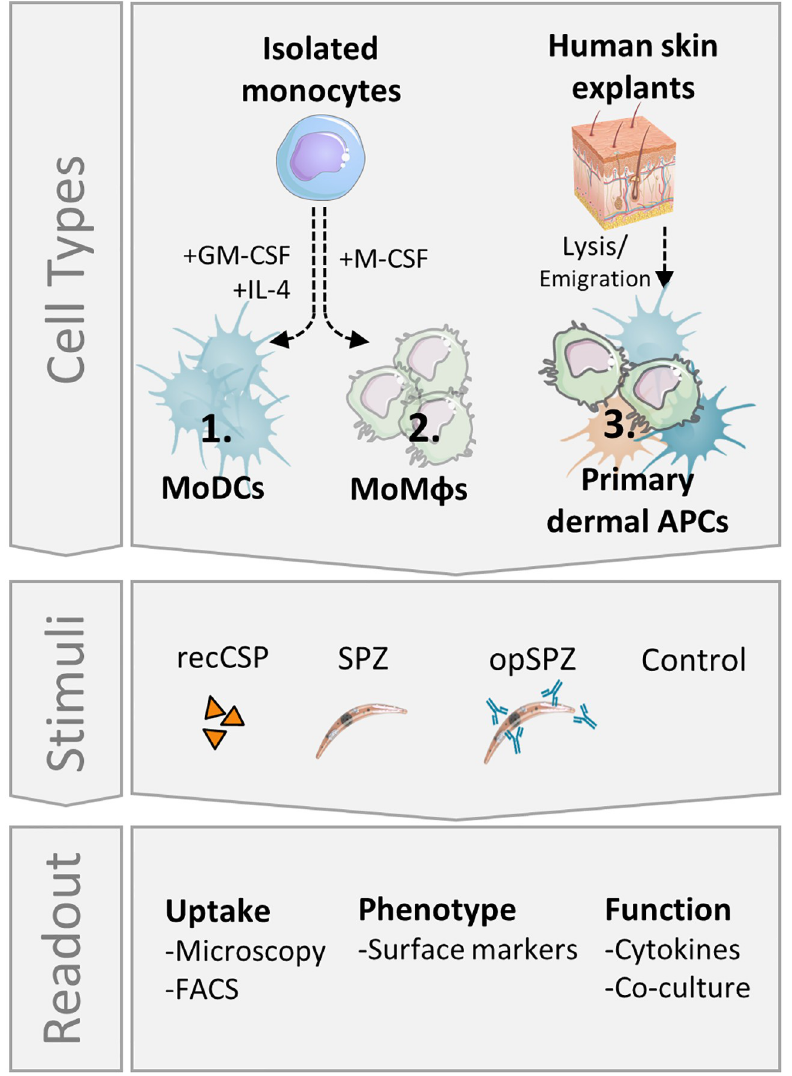
Fig 1. Experimental setup. MoDCs and MoM ϕ s were differentiated in vitro from freshly isolated monocytes. Additionally, fresh human skin explants containing primary dermal APCs were lysed to form a single cell suspension. All cell types were stimulated in vitro with recombinant SPZ surface antigen, circumsporozoite protein (recCSP) or whole sporozoites (untreated: SPZ or opsonized: opSPZ). Uptake of recCSP and (op)SPZ was determined by confocal microscopy and flow cytometry. Subsequently, cells were analyzed for their phenotype and function. Images of skin and sporozoite were reproduced. They were purchased for publication at